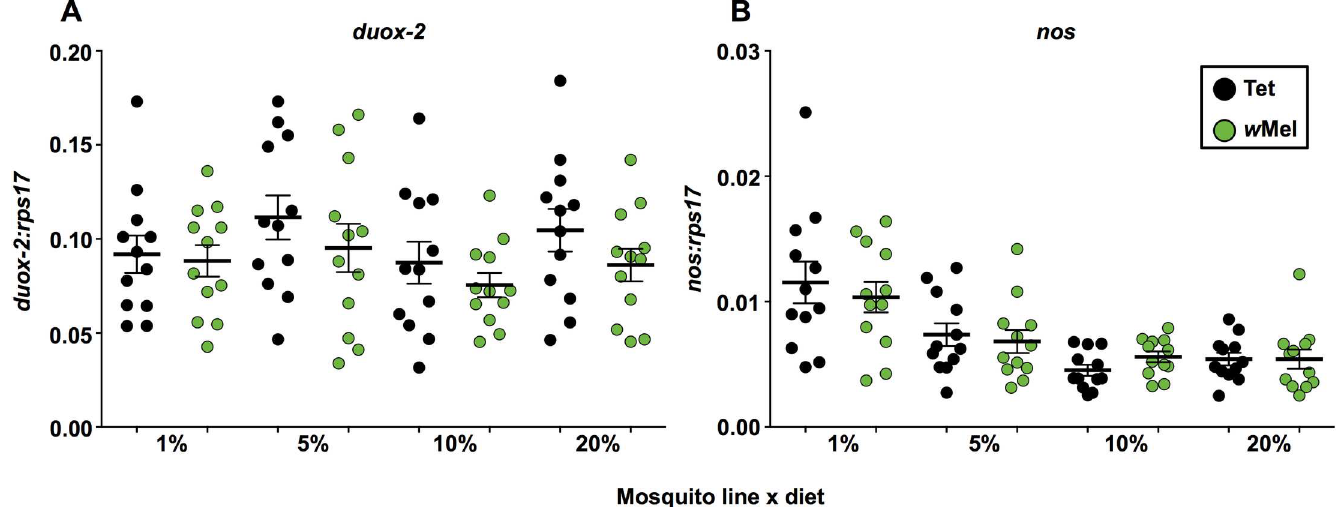
Fig 5. Levels of key oxidative stress response genes in w Mel-infected Ae . aegypti fed on different carbohydrate regimes. Levels of Dual Oxidase 2 ( duox-2 ) (A) and Nitric Oxide Synthase ( nos ) (B) were quantifiedfor Tet (- Wolb )and w Mel (+ Wolb ) mosquitoesusing RT-qPCR. Gene expressionvalues were normalizedagainsthost rps17 expression. Each circle represents one pair of either Tet (black circles) or w Mel (green circles) mosquitoes, with 12 samples examinedper treatment. Solid black lines representmean expression( ± s.e.m.). P values: Generallinear models, ** < 0.01, *** < 0.001.